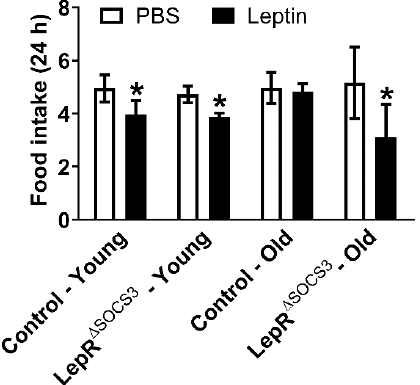
Figure 3. LepR ∆ SOCS3 mice are protected against aging-induced leptin resistance. Twenty-four hour food intake after an i.p. injection of PBS or leptin (2.5 µg/g body weight) in young adult (3-month-old) control ( n = 6) and LepR ∆ SOCS3 ( n = 7) mice and in middle-aged (15-month-old) control ( n = 7) and LepR ∆ SOCS3 ( n = 4) mice. Mean ± SEM. * p < 0.05 control vs. LepR ∆ SOCS3 (post-hoc test repeated measures two-way ANOVA).